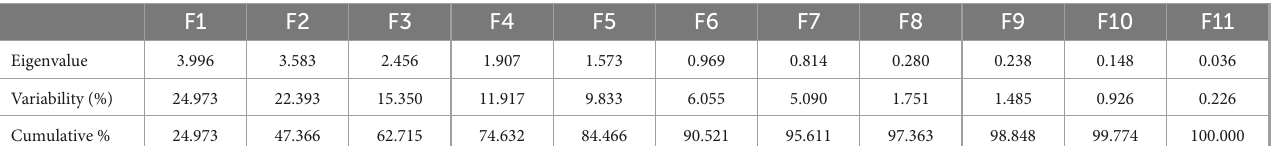
TABLE 5 Principal component analysis of different fruit peel varieties.